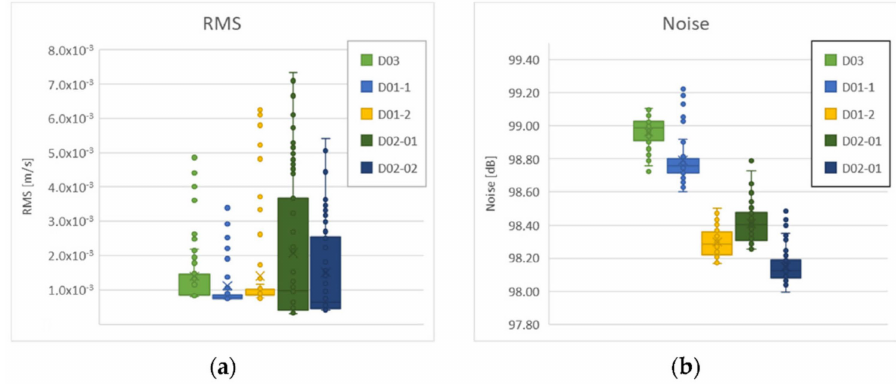
Figure 13. RMS measurement results ( a ); noise level measurement results ( b ).